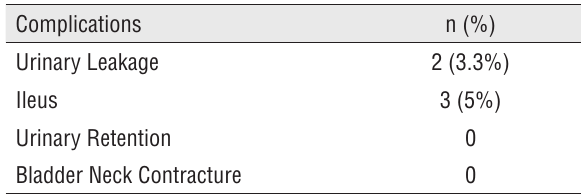
Table 4 - complications related to vuA.